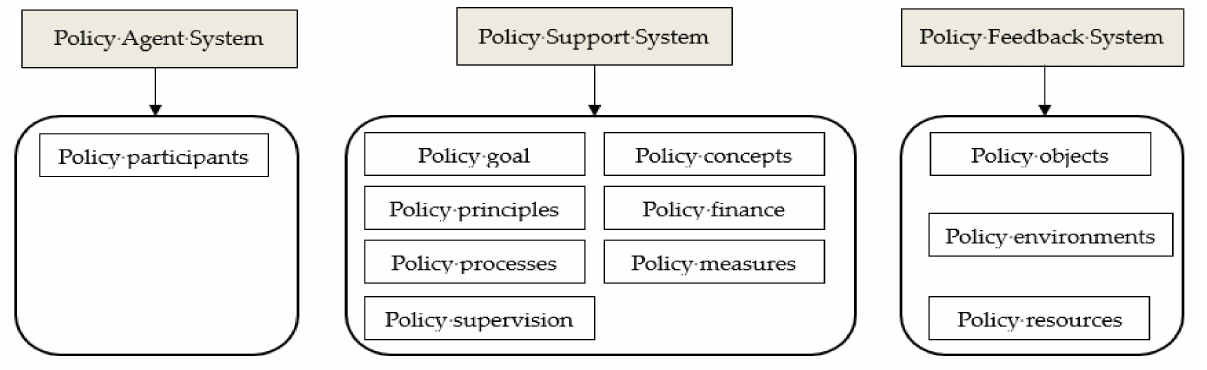
Figure 4. The framework of policy analysis. Table 3. Axial coding and selective coding table